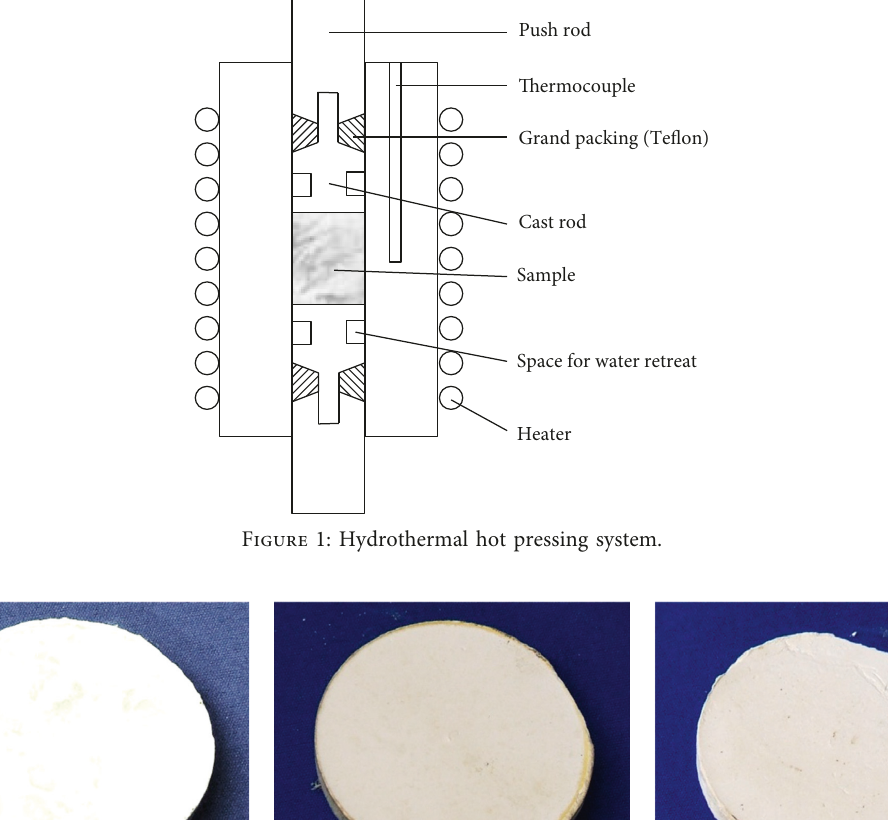
° C, 3 -chitosan composite prepared at 4